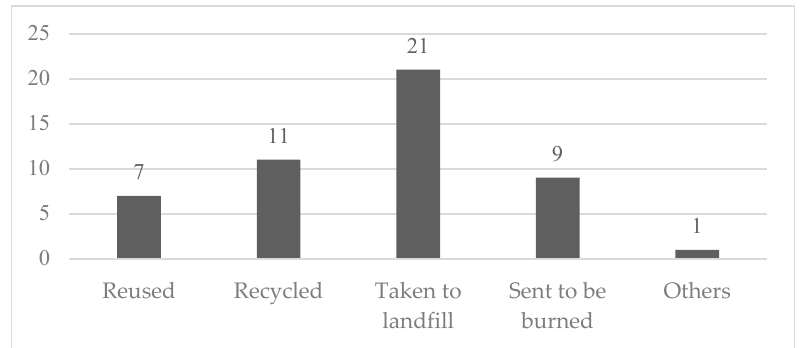
Figure 3. Frequency of using different disposal methods of building material